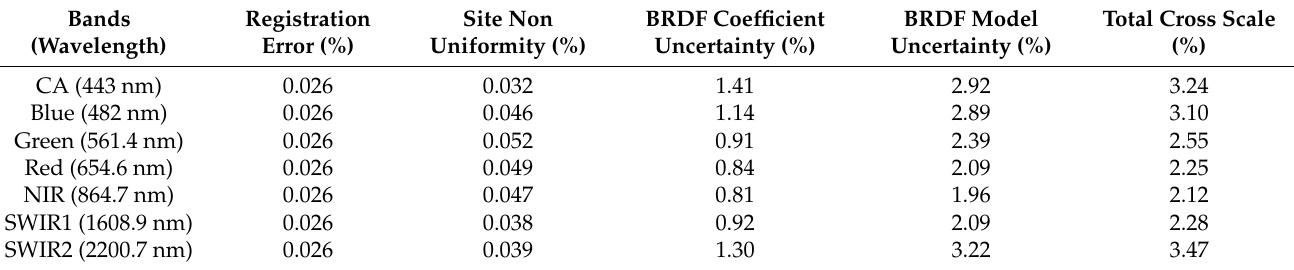
Table 9. Summary of cross-scale factor uncertainty.